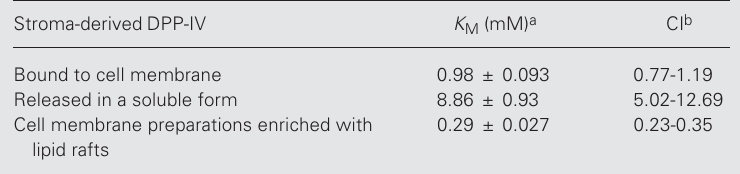
Table 3. The apparent K M for dipeptidyl peptidase IV (DPP-IV) from hematopoietic stroma cells. Stroma-derived